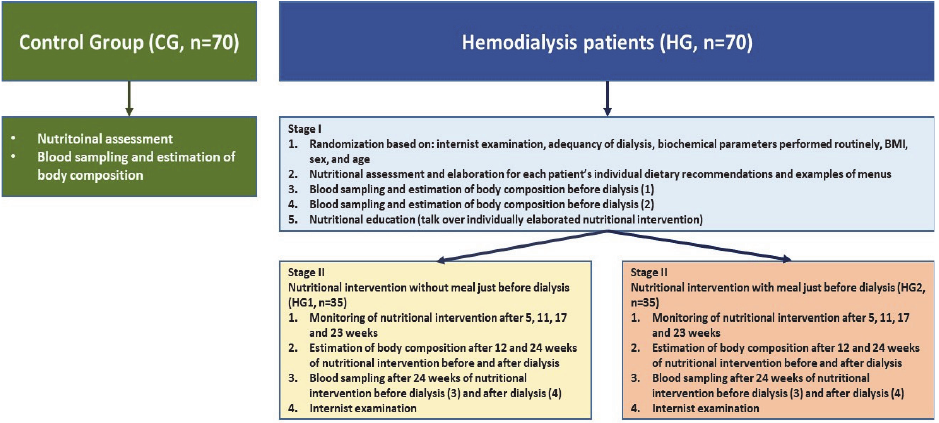
Figure 1. The work plan of the studies: healthy people (control group, CG) and nutritional intervention in 2 homogeneous groups of patients treated with hemodialysis.